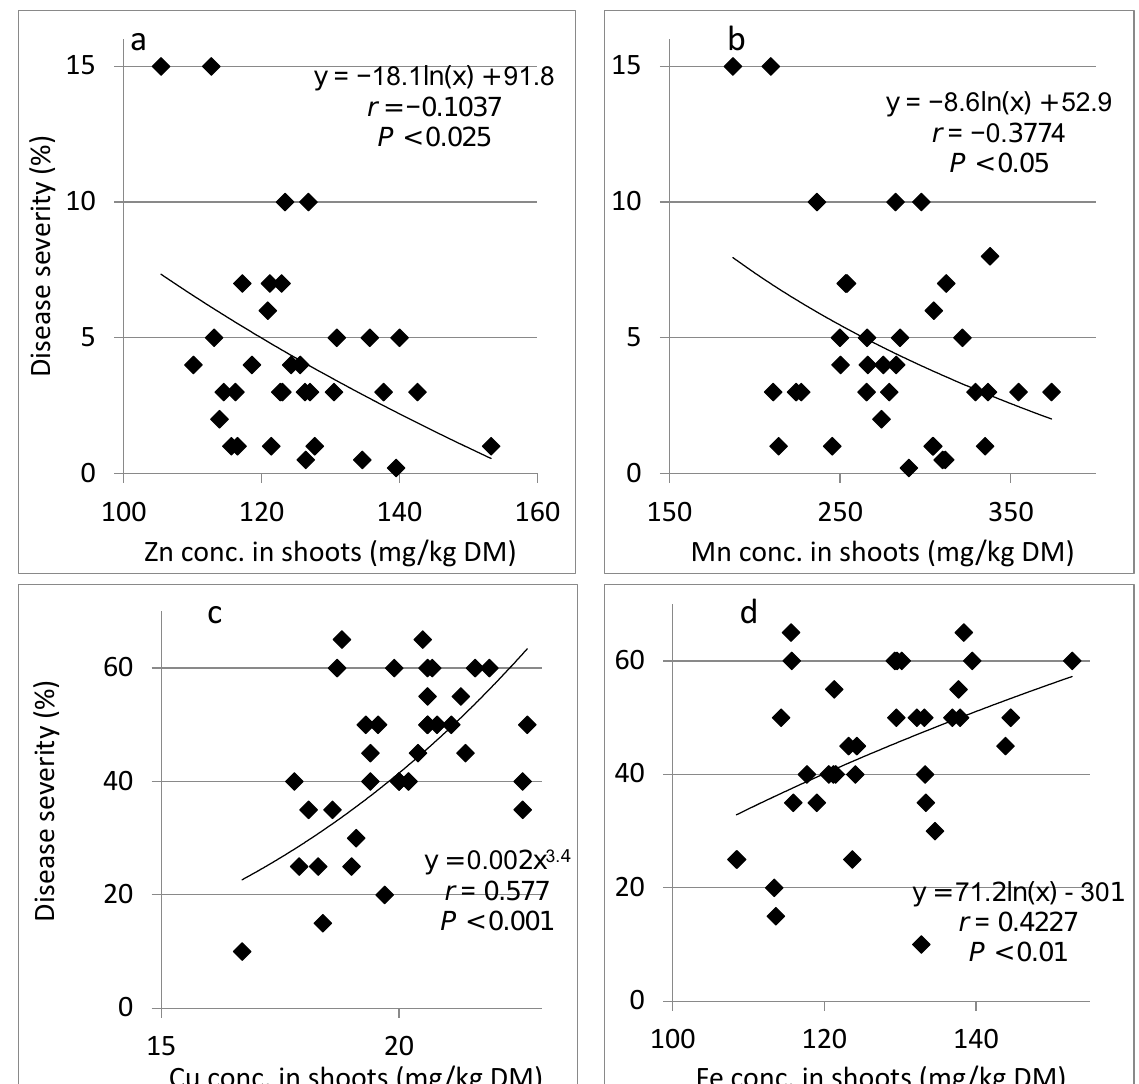
Figure 3. Relationships between the concentrations of microelements ( a ) Zn, ( b ) Mn, ( c ) Cu and ( d ) Fe in shoots of sweet basil sampled in single plots of Experiment C1 at 94 days after planting and the severity of sweet basil downy mildew (SBDM). SBDM severity was evaluated on a 0 – 100% scale, in which 0 = healthy plants and 100% = plants completely covered by disease symptoms. The best-fit regression formula is presented for each microelement. Pearson regression values ( r ) are presented along with significance levels ( P ).